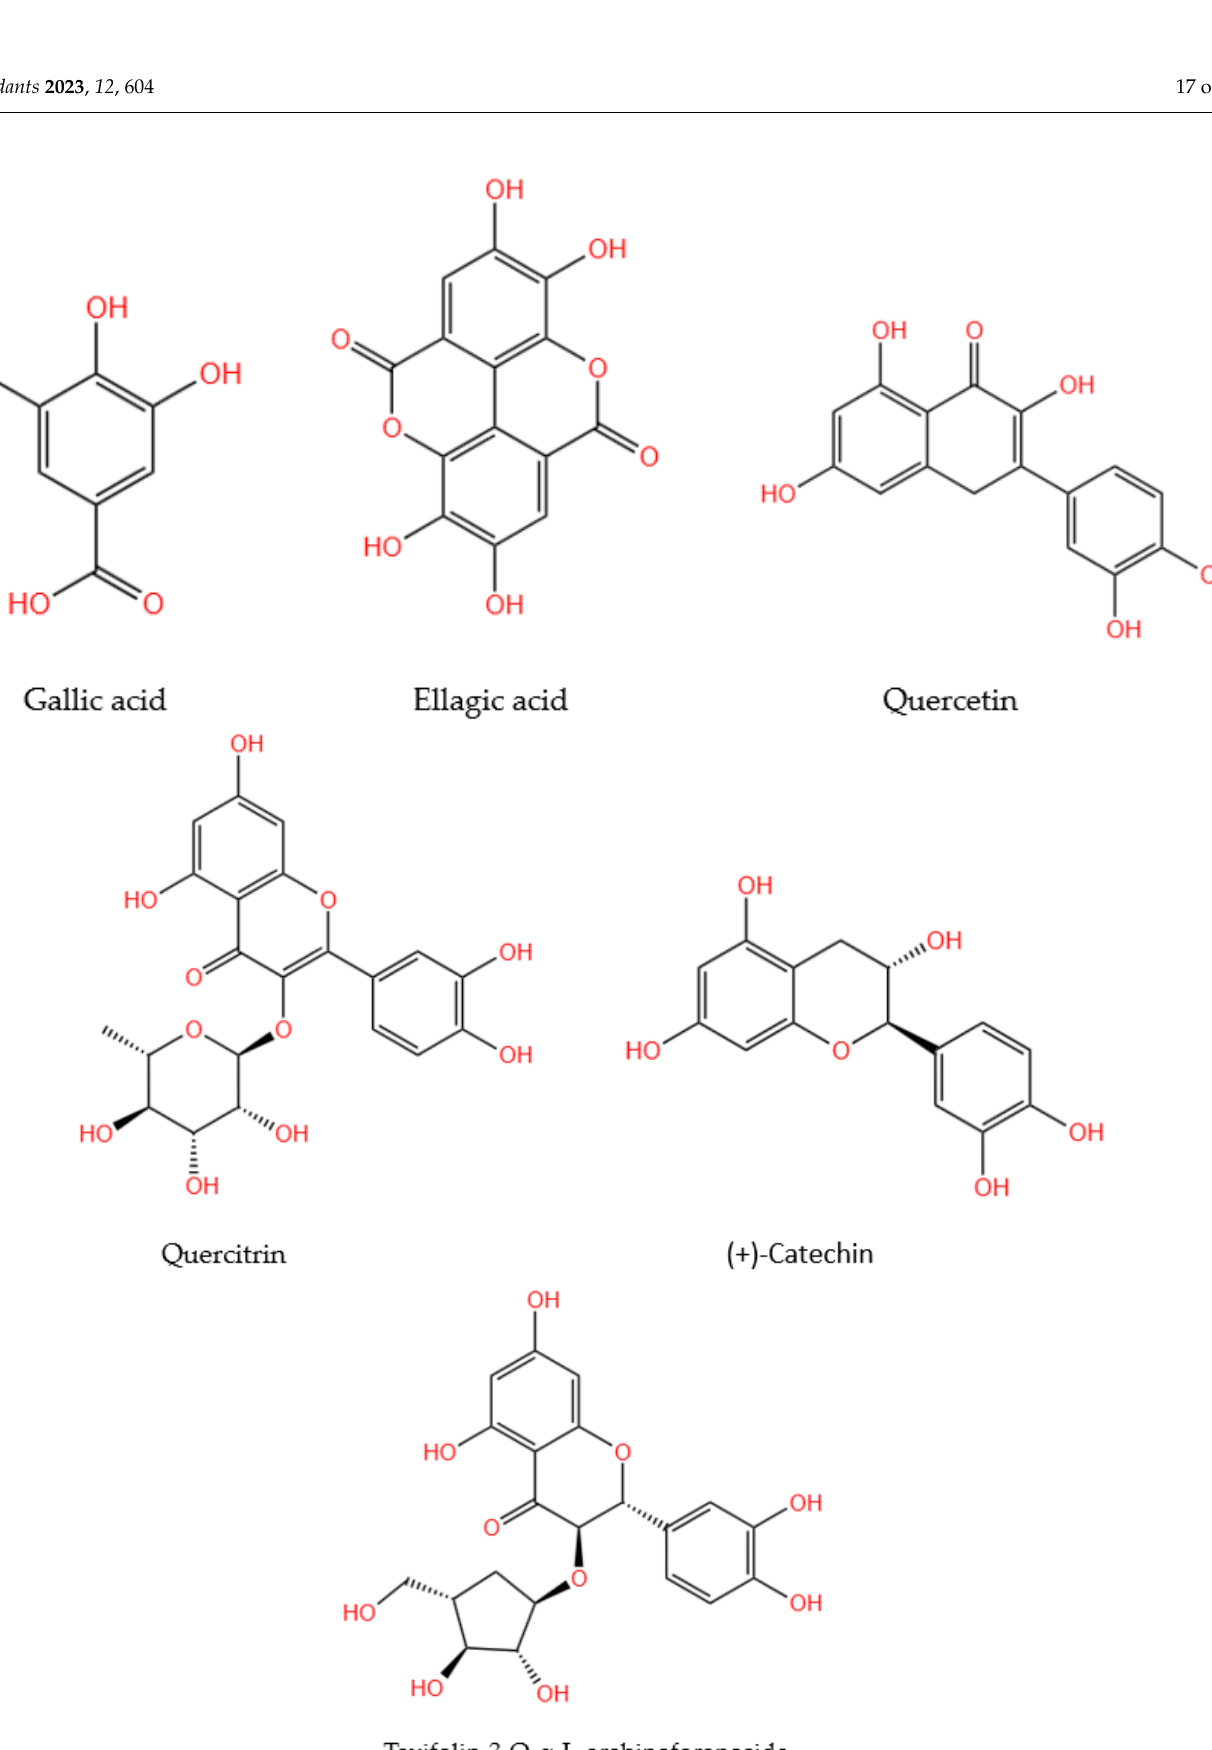
Figure 2. Chemical structures of the main phenolic compounds identified and quantified in walnut septum.